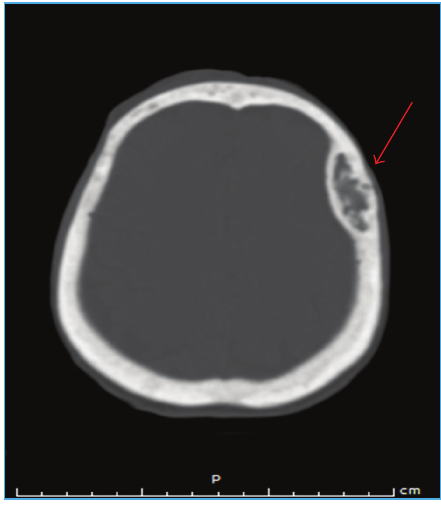
Figure 2: Noncontrast head scan showing expansible lytic “lacelike” lesion (4 × 1.3cm) of left frontal bone (red arrow) with sclerotic bor- der and amorphous calcifications or “unformed” deposit of calcium and without periosteal reaction. Note also the general sclerosis and the lack of normal appearance of diploica of